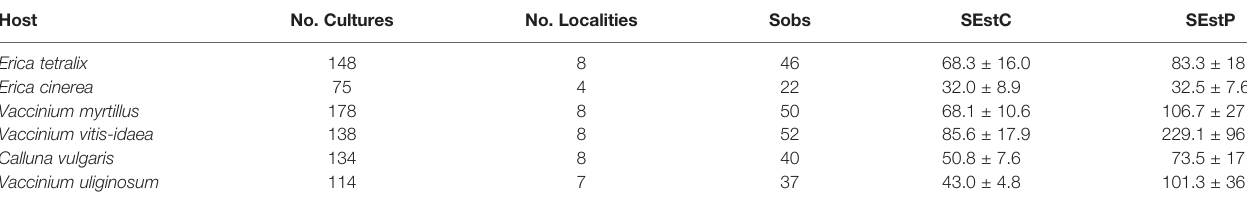
TABLE 2 | Observed and estimated species richness associated with six hosts collected across eight Norwegian coastal heathlands.